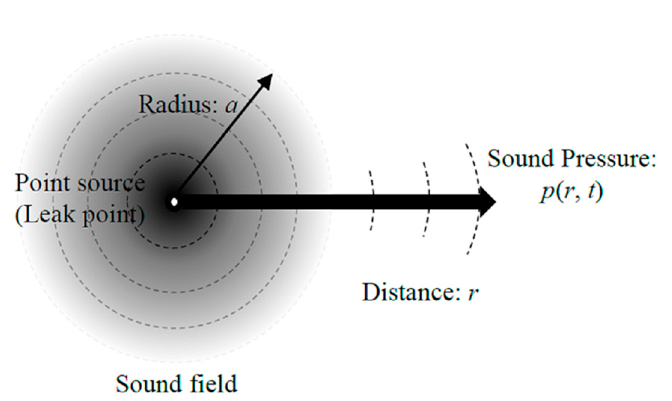
Figure 3. Thus, the acoustic wave equation of the point source sound field and its solution are deduced as Equations (2) and (3), respectively.